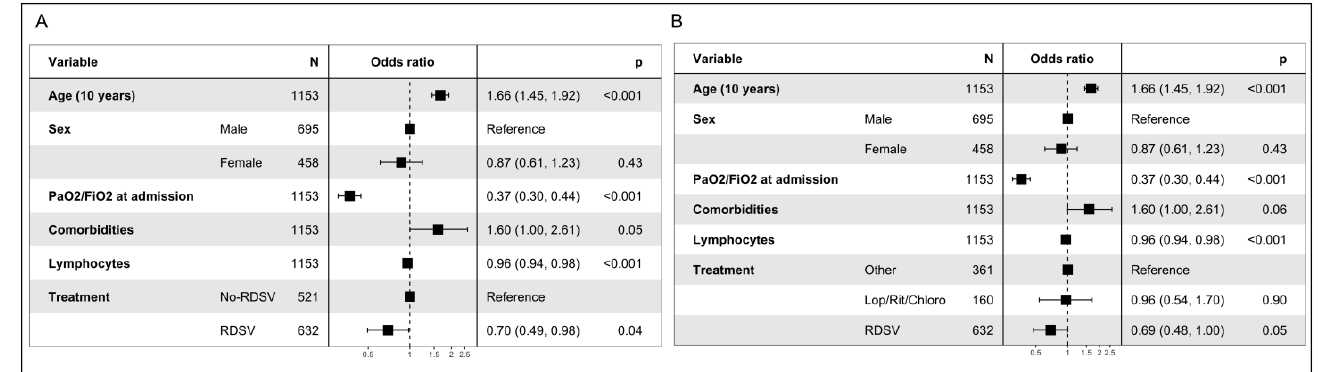
Figure 3. Multivariable analysis of factors associated with the composite endpoint.